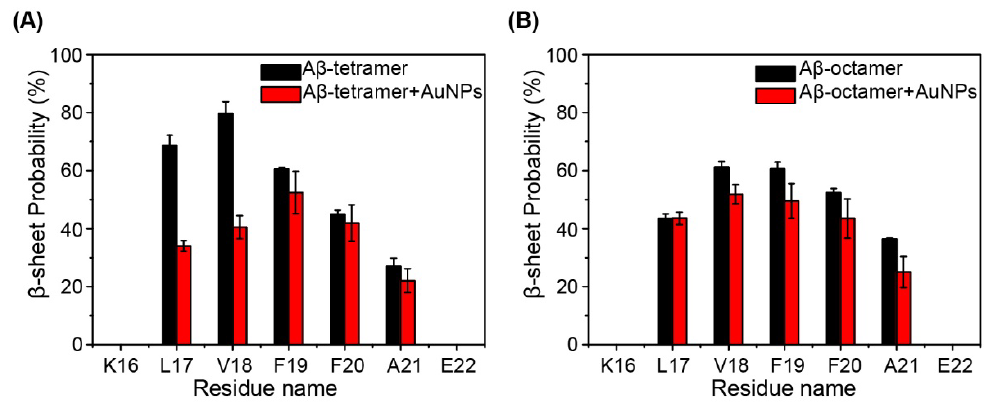
Figure 2. Calculated β - sheet probability of each residue of Aβ (16 -22) peptides in ( A ) the Aβ tetramer system (red) and Aβ tetramer + AuNPs system (black) and ( B ) the Aβ octamer system (red) and the Aβ octamer + AuNPs system (black).